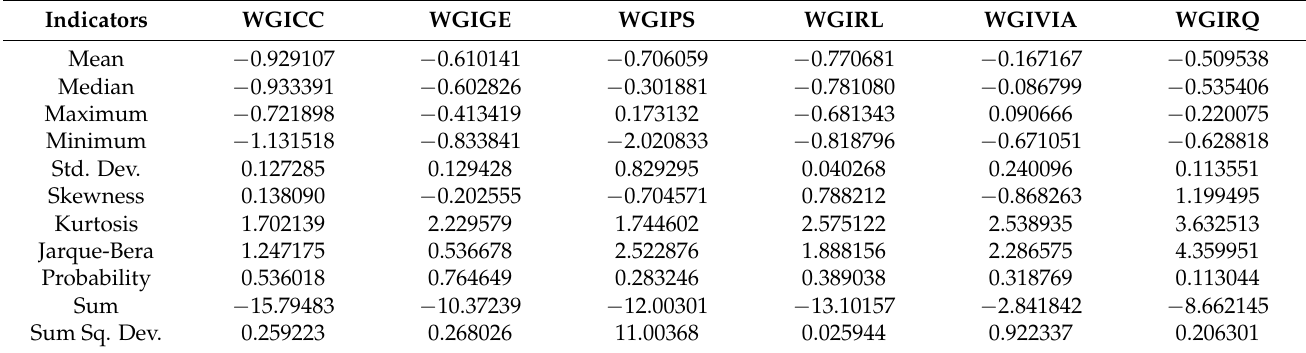
Table 2. The descriptive statistics of WGI for Ukraine, 2002–2019 (Source: developed by the authors).